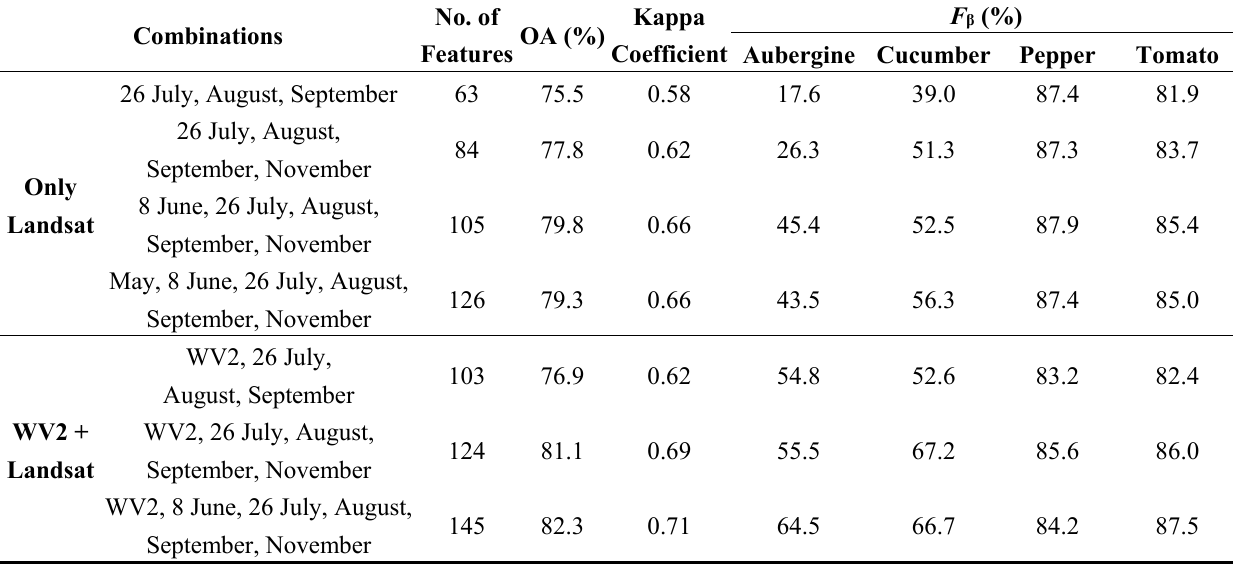
Table 7. Accuracy indices from different combinations of multi-temporal orthoimages using the no GLCM strategy. Combinations